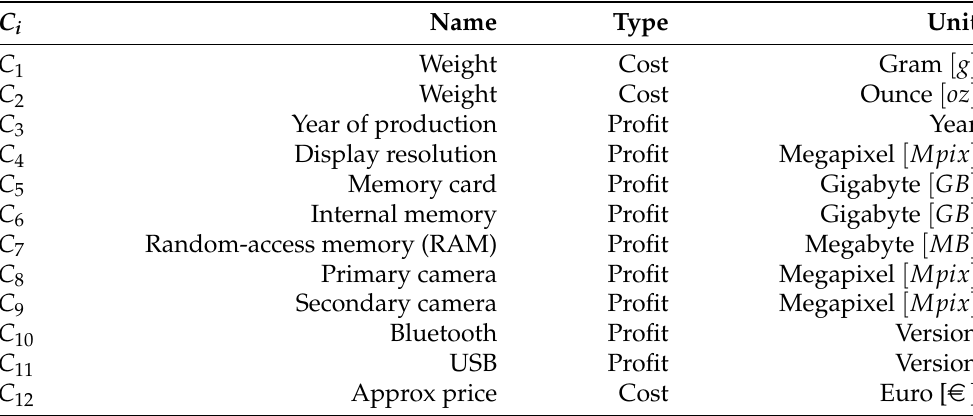
Table 2. Selected criteria C 1 – C 12 , their name, type, and